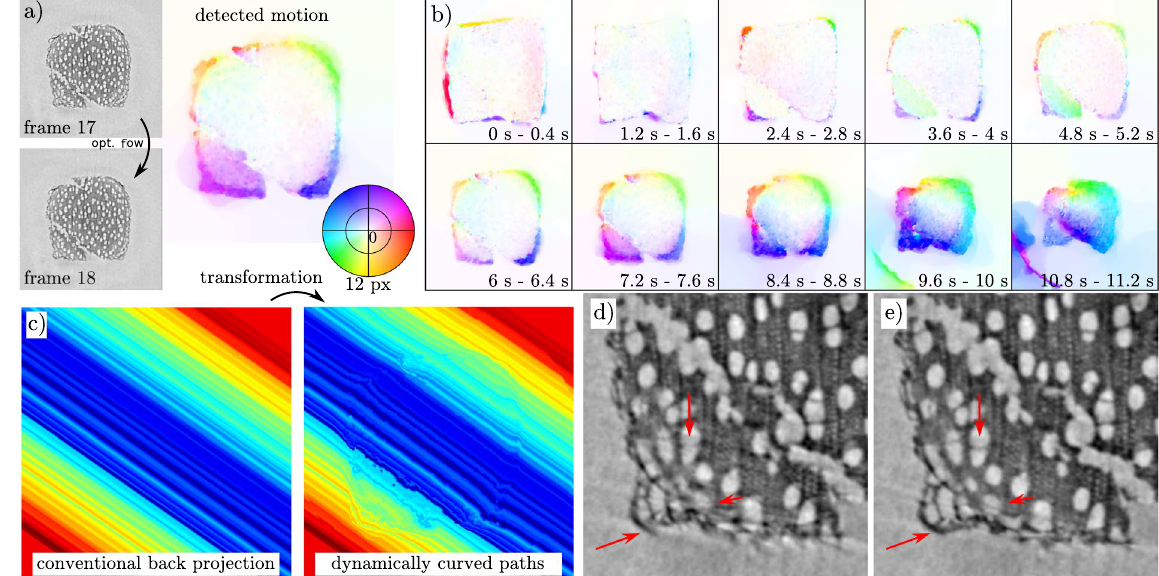
Figure 4. Illustration of the motion estimation for the subsequent backprojection along curved paths. Two successive reconstructions ( a ) are analyzed by an optical flow algorithm. The depicted result shows the shrinking at the borders of the match. The color indicates the direction of motion as shown by the color wheel, the saturation gives the motion amplitude with a maximum of 12 px for all images shown. The image series in ( b ) gives an overview of the dynamics of the entire burning process, showing the optical flow result for every third frame. Using the motion information, the reconstruction is the carried out by backprojection on dynamically curved paths, as illustrated in ( c ) with a magnification of the motion amplitude by the factor of 3 for better visibility. A significantly improved reconstruction quality is observed, see the fine object details resolved in ( e ), compared to the result of ( d ) a conventional direct FBP reconstruction.